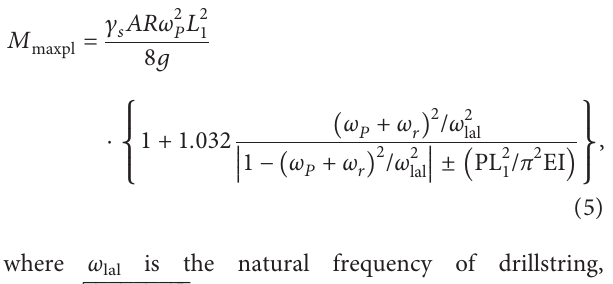
� whirl angular p